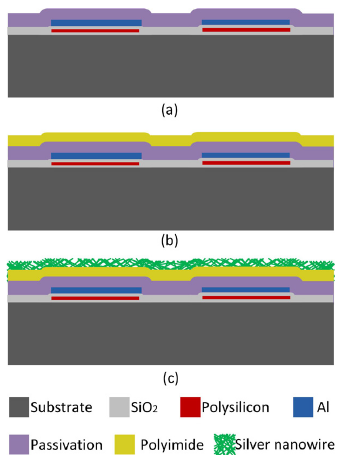
Figure 3. Fabrication process of the humidity sensor: ( a ) interdigitated structure fabricated by a complementary metal oxide semiconductor (CMOS) process, ( b ) structure after deposition of a polyimide film ( c ) structure after deposition of a silver nanowire electrode.